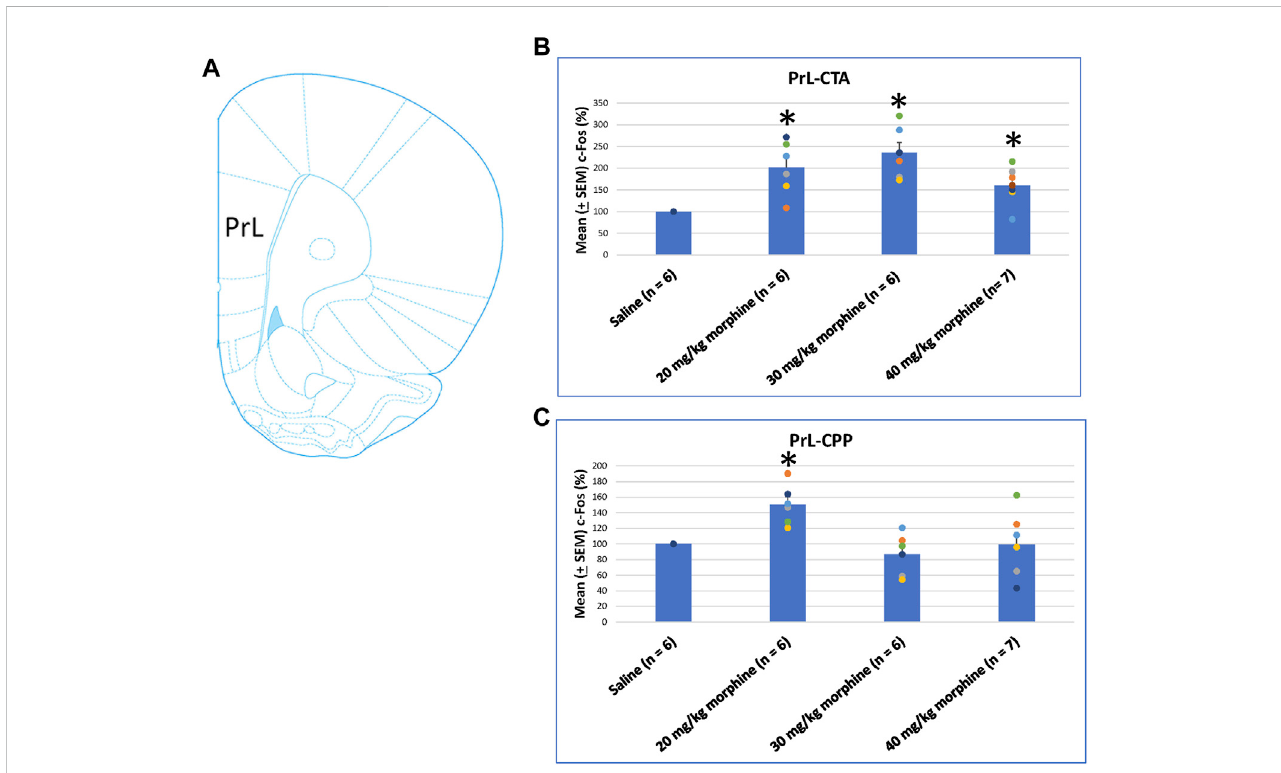
FIGURE 7 (A) Representativeimageofc-Fosimmunoreactivityintheprelimbiccortex(PrL).Mean(±SEM)c-Fos(%)inPrLinthefollowing (B) CTAand (C) CPPtests. * p < 0.05 when comparing the saline for CTA and CPP (both, n = 6) or with morphine in doses of 20 mg/kg for CTA and CPP (both, n = 6), 30 mg/kg for CTA and CPP (both, n = 6), and 40 mg/kg for CTA ( n = 6) and CPP ( n =